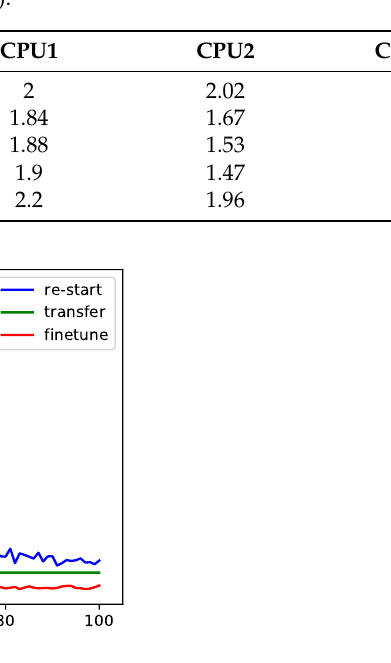
Table 2. RMSE results for transfer learning (°C).